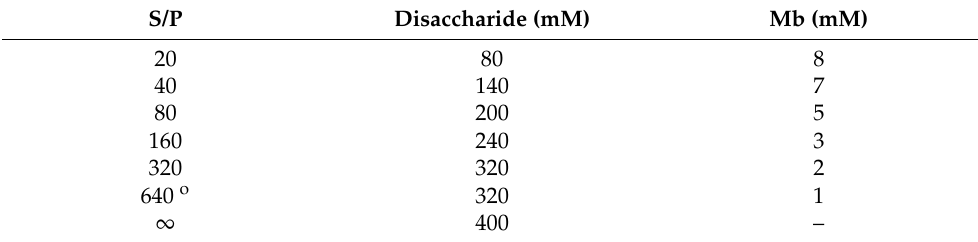
Table 2. Molar concentration of disaccharides and protein used to prepare the samples.